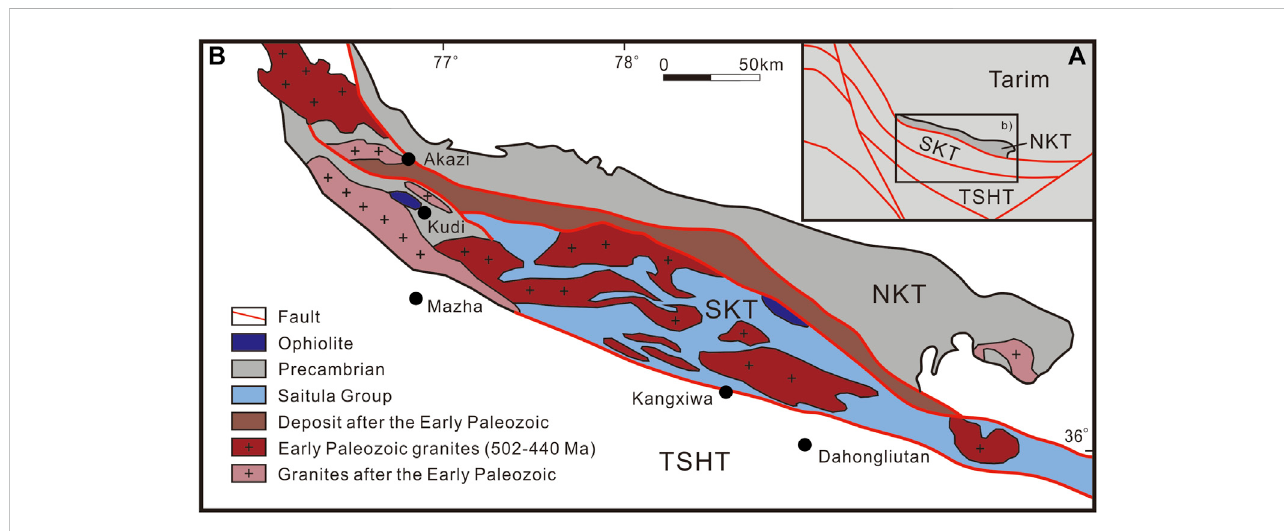
FIGURE 10 Location (A) and tectonic framework (B) of the West Kunlun orogenic belt and its adjacent areas (NKT: The North Kunlun terrane, which is a part of the Tarimblock;SKT:TheSouthKunlunterrane,whichcancorrespondtotheCentralandSouthKunlunterraneinearlyPaleozoic;TSHT:TheTianshuihaiterrane) (modi fi ed after Zhang L. N. et al.,